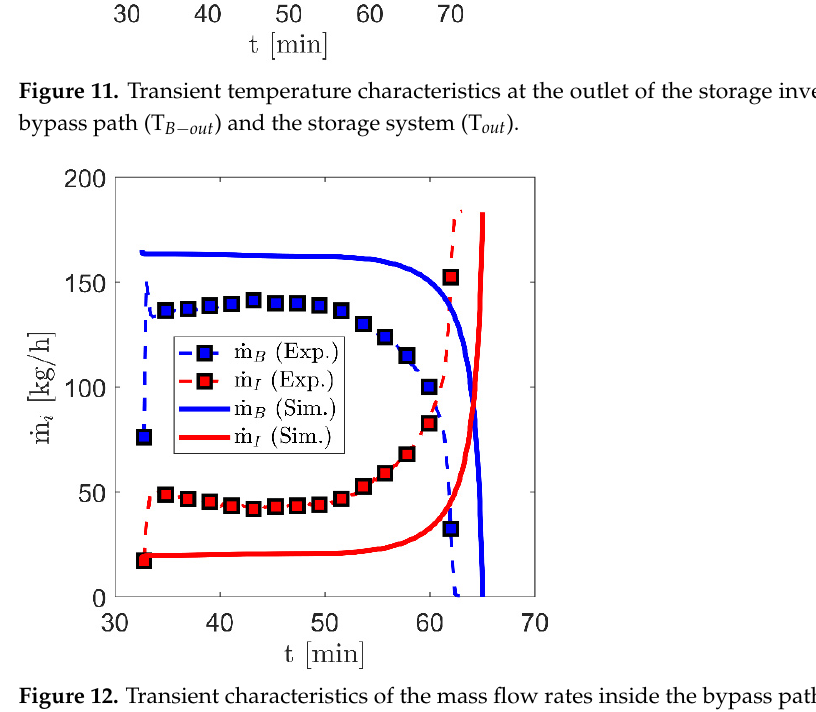
Figure 12. Transient characteristics of the mass flow rates inside the bypass path ( m(cid:4662) (cid:3003) ) and storage inventory ( m(cid:4662) (cid:3010) ).